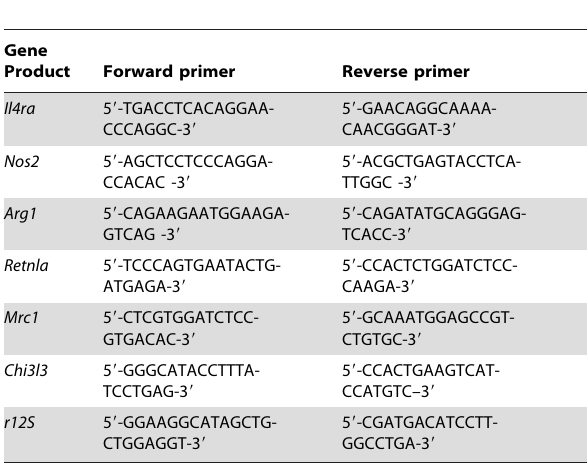
Table 1. List of gene-specific primer pairs used for quantitative real-time